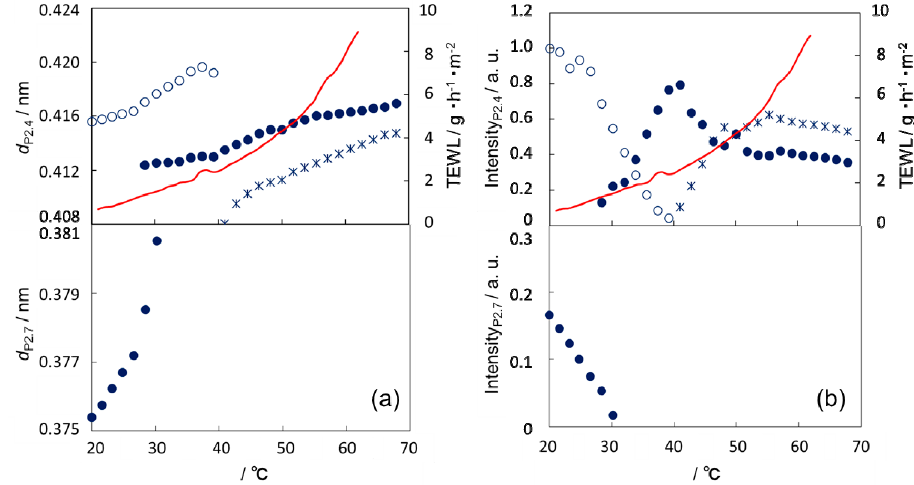
Figure 6. Comparison of TEWL with WAXD of human SC in cooling. ( a ) Lattice spacings calculated from the positions of P 2.7 ( ● ) and deconvoluted peak(s) ( ◌ , ×, and ● ) as described in Figure 4b and ( b ) their peak intensities are shown as functions of temperature, together with TEWL data shown in Figure 3c.